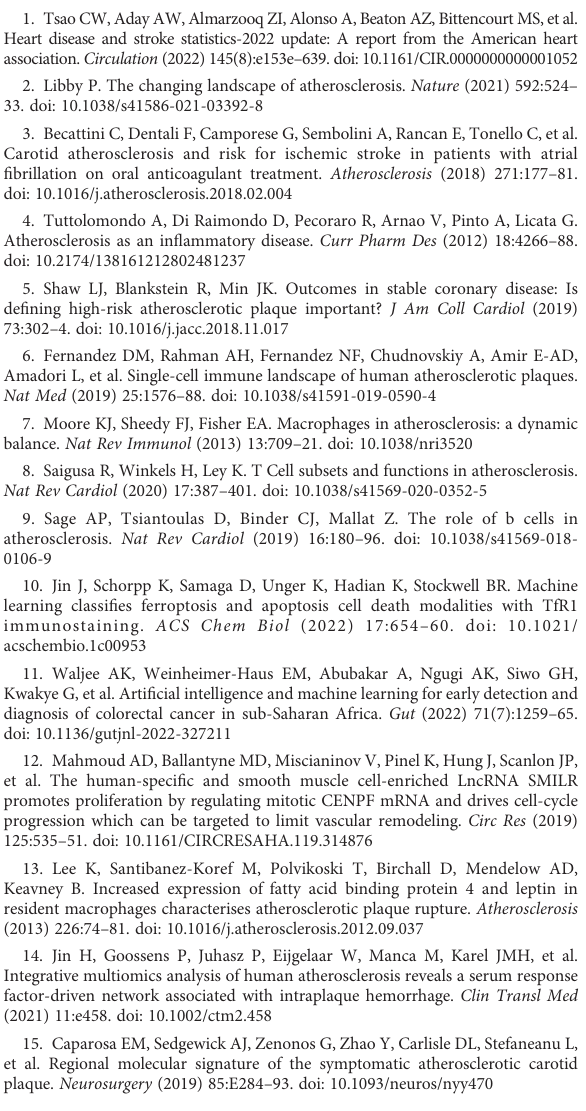
SUPPLEMENTARY FIGURE 4 Cell Annotation by signature markers in scRNA-seq data. Heatmap of the expression levels of representative marker genes of the atherosclerotic plaque clusters. The color represents the gene expression levels. SUPPLEMENTARY FIGURE 5 Correlation of DEGs and key immune cell types. (A) Heatmap shows Spearman correlation between DEGs and immune cells. (B) Network between key DEGs and key immune cell types. Red lines represent positive correlation while blue ones represent negative correlation. Immune cell types are colored in orange while genes are colored in blue. SUPPLEMENTARY FIGURE 6 Potential biomarkers for unstable plaques. Diagnostic effectiveness of the potential biomarkers by ROC analysis in the training set and validation data